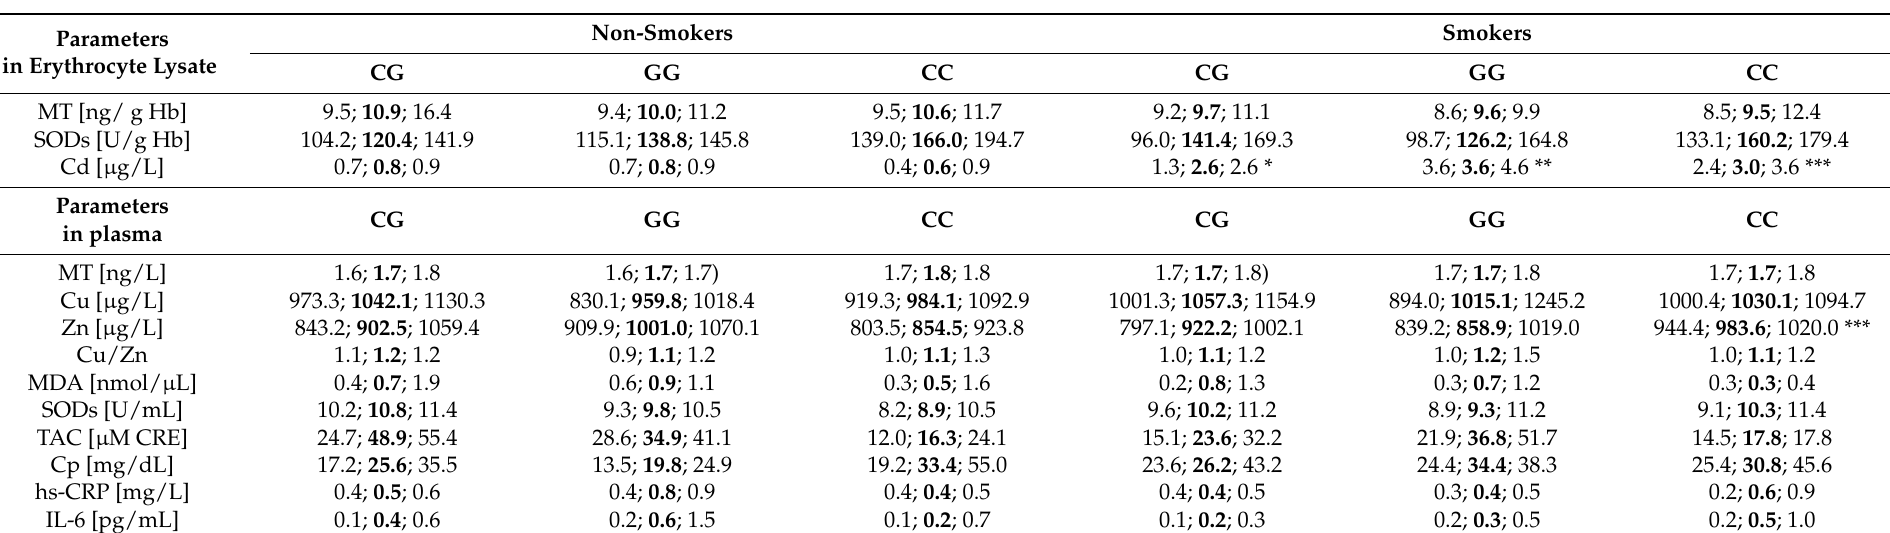
Table 5. The concentration of metals (Cu, Zn and Cd), MT, Cp and markers of inflammation and oxidative stress in groups of non-smoking and smoking healthy subjects, with regard to genotypes for rs964372 in the MT1B gene. The bold is to distinguish the median values.